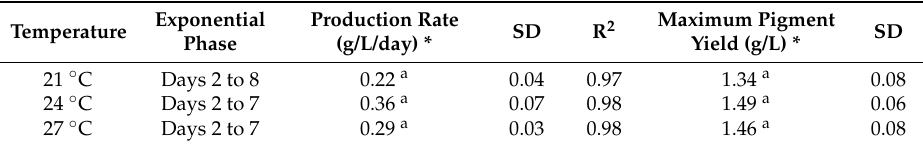
Table 2. Pigment production rate (in terms of Monascus red rice equivalents) from T. albobiverticillius